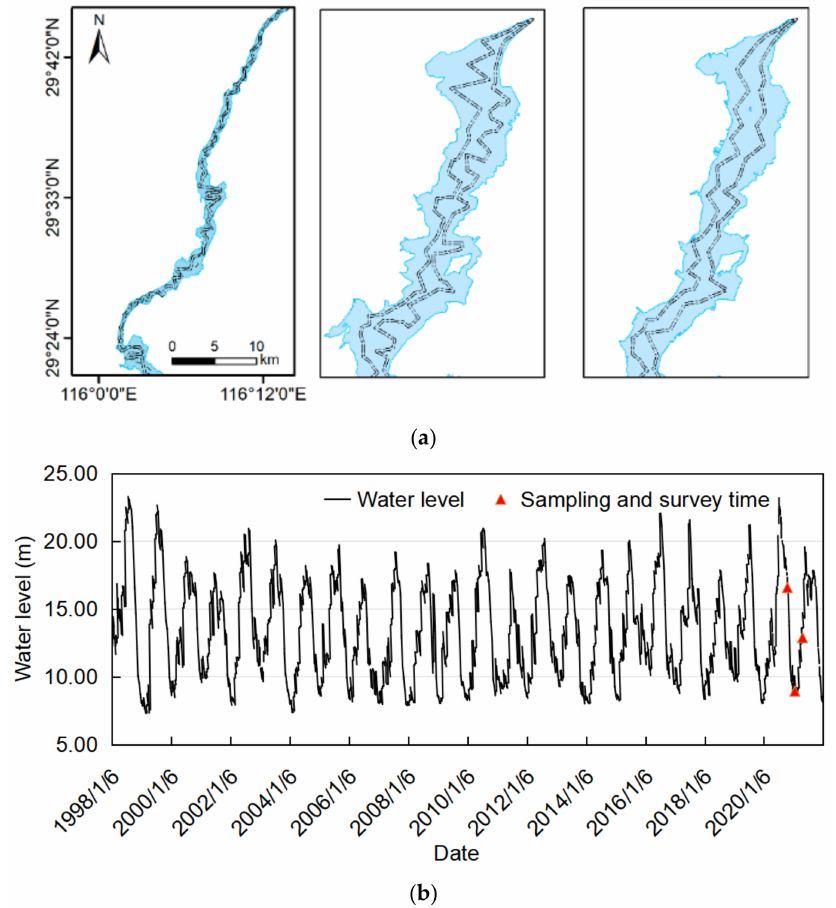
Figure 2. ( a ) Navigation route of hydroacoustic surveys during October 2020, January 2021, and April 2021(from left to right). ( b )Water-level variation at the Hukou hydrological station (Hukou, Jiangxi, China) during the period 1998–2021. Table 1. Summary of hydroacoustic data for the four major Chinese carps during three typical water conditions. (We only show a part of the low water level period. See the attached Table S1 for the full